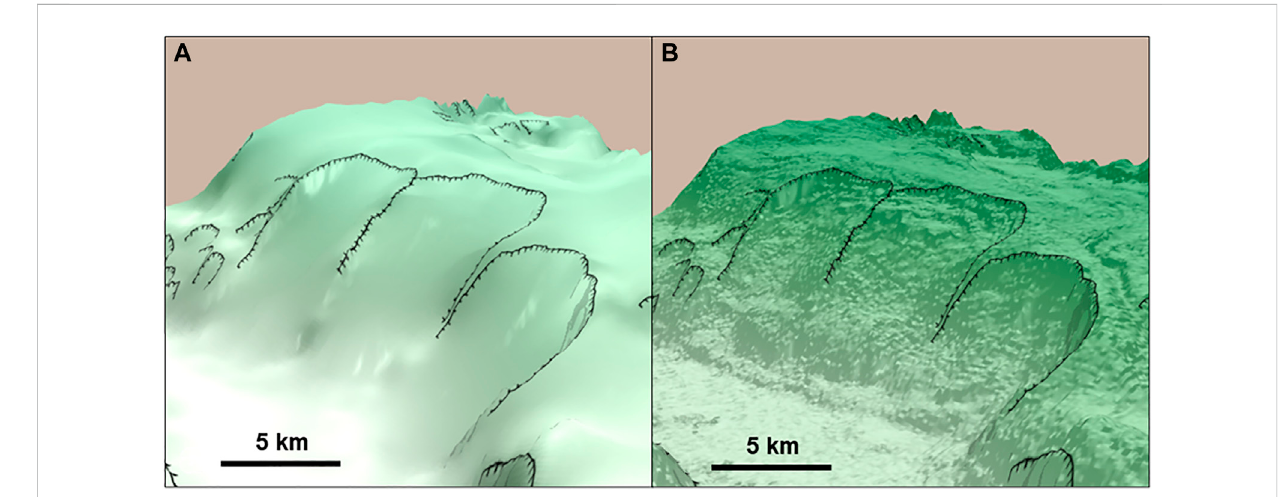
FIGURE 3 Three-dimensional (3D) perspective of the modeled pre-landslide and the present surface of the submarine landslides. (A) The modeled pre- landslide is calculated based on the multi-level b-spline calculation at a coarser 100 x 100 m resolution around the perimeter of the submarine landslide that represents the intact slope. (B) The present surface DEM serves as the base, whereas the modeled pre-landslide is the top surface for estimating the slump